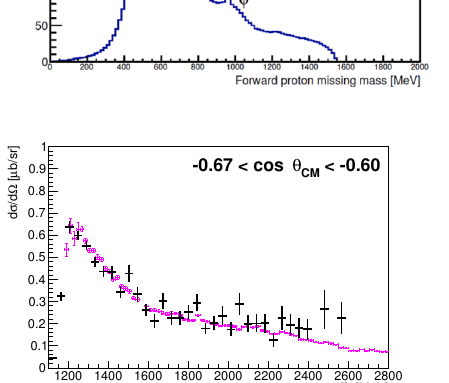
Figure 4. Missing mass spectrum optained from tagged beam photon and forward proton measured in the OD spectrometer.